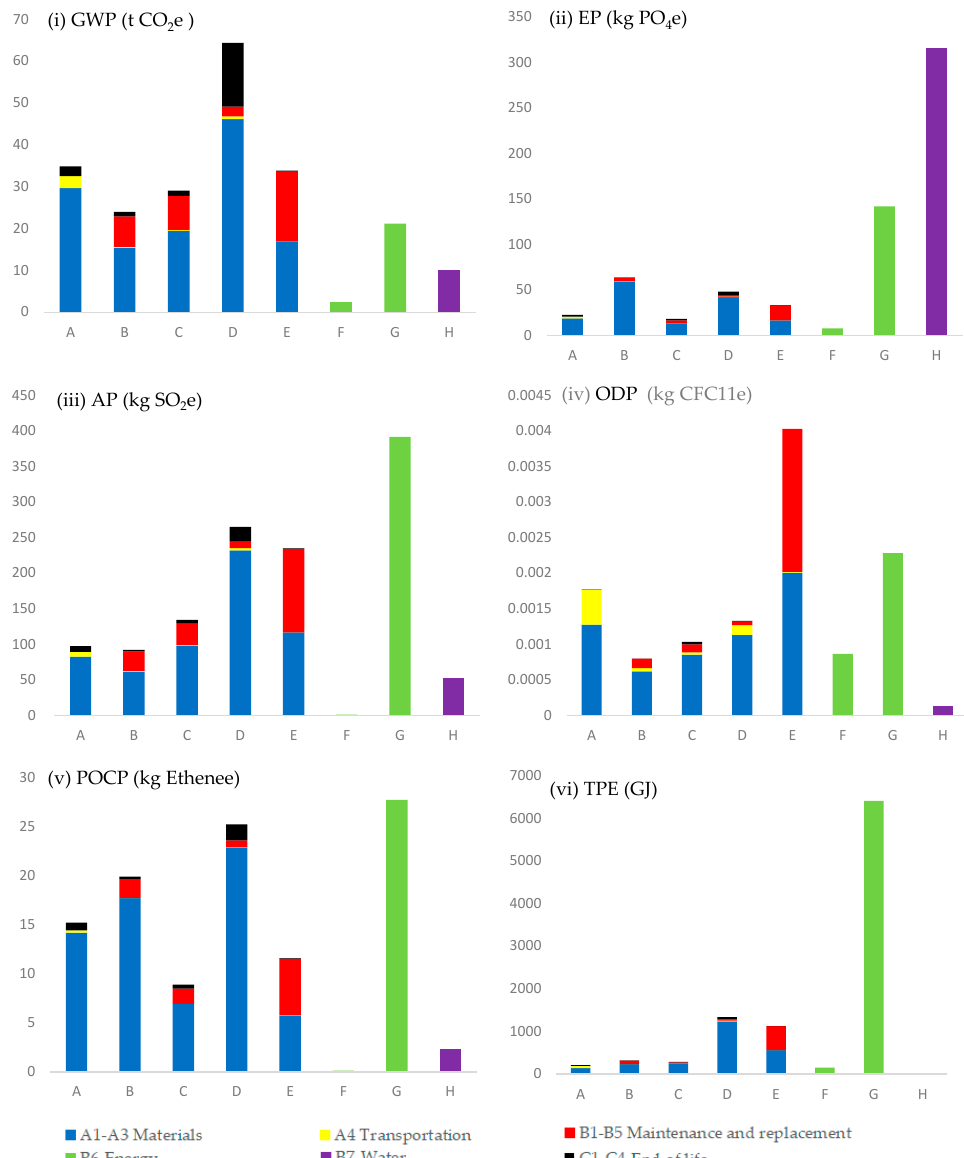
Figure 5. ( i – vi ): The contribution of the An Corr á n building structures, energy, and water usage (A–H, see legend below), by life cycle stage, to the six environmental impacts that were assessed. Legend: GWP = Global Warming Potential, EP = Eutrophication Potential, AP = Acidification Potential, ODP = Ozone Depletion Potential, POCP = Photochemical Ozone Creation Potential, PE = Total Primary Energy excl. raw materials, A = Foundation, sub-surface, basement, retaining walls; B = External walls and façade; C = Internal walls and non-bearing structures; D = Floor slabs, ceilings, roofing decks, beams, roof; E = Windows and doors; F = Electricity use; G = Fuels used in nearby or on-site heat suppliers; H = Total water